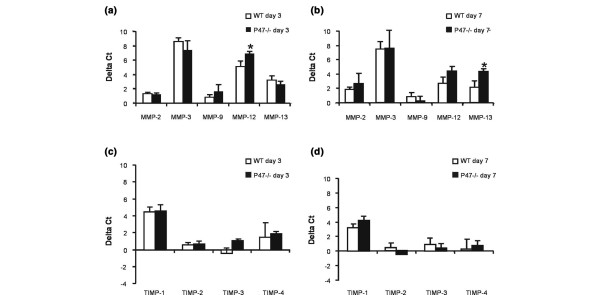
mRNA levels of various MMPs and TIMPs in cartilage layers derived from inflamed knee joints. Cartilage layers were isolated from patellae and tibia, three and seven days after IFN-γ accelerated arthritis. The cycle threshold value (Ct) of the various MMP and TIMP genes was corrected for glyceraldehyde-3-phosphate dehydrogenase content and t = 0. Note that at day 3, MMP-12 and at day 7 MMP-3 mRNA levels were significantly elevated in p47phox-/- mice when compared to controls (6A and B). TIMP mRNA levels were not altered (6C and D).